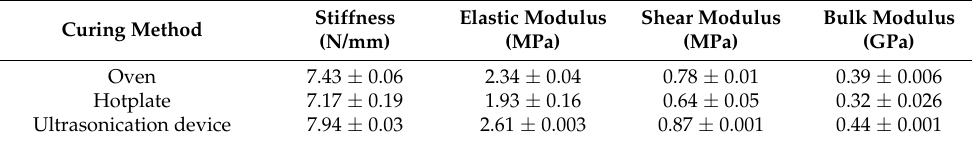
Table 3. Mechanical properties of the PDMS thin films under different curing